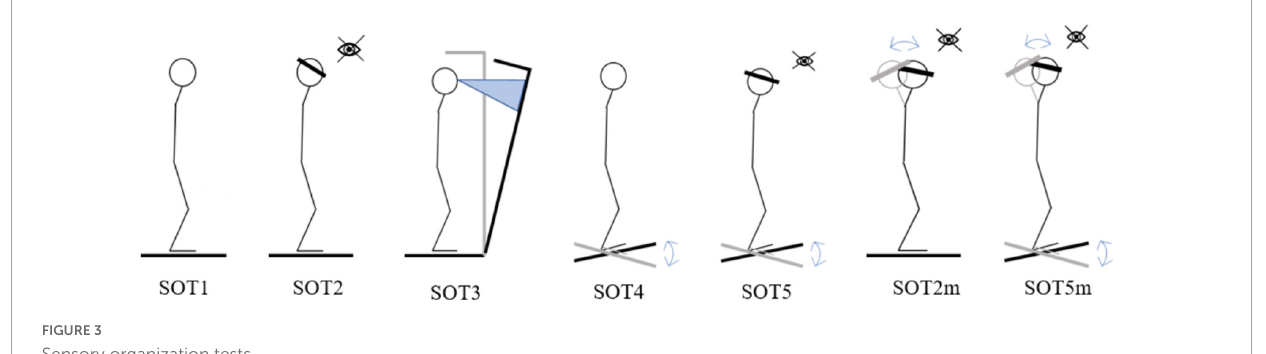
FIGURE3 Sensory organization tests.